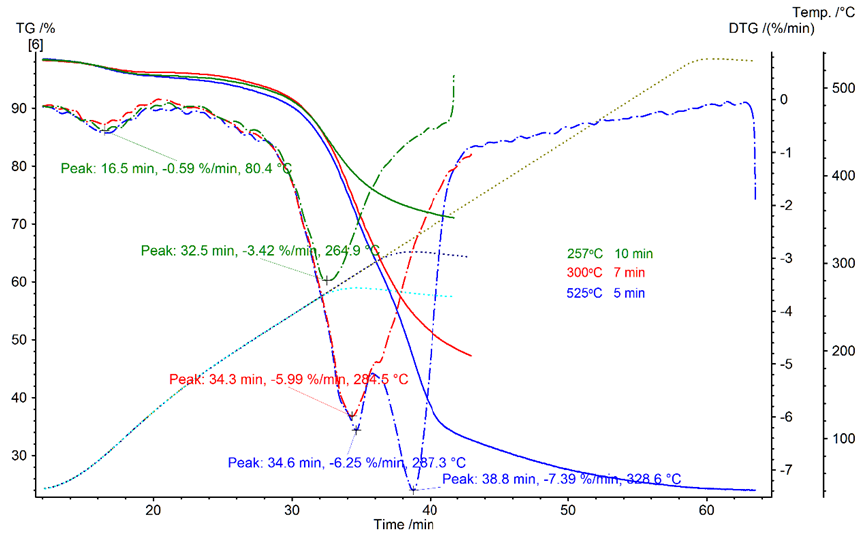
Figure 13. Summary of maize straw torrefaction curves with DTG curves.